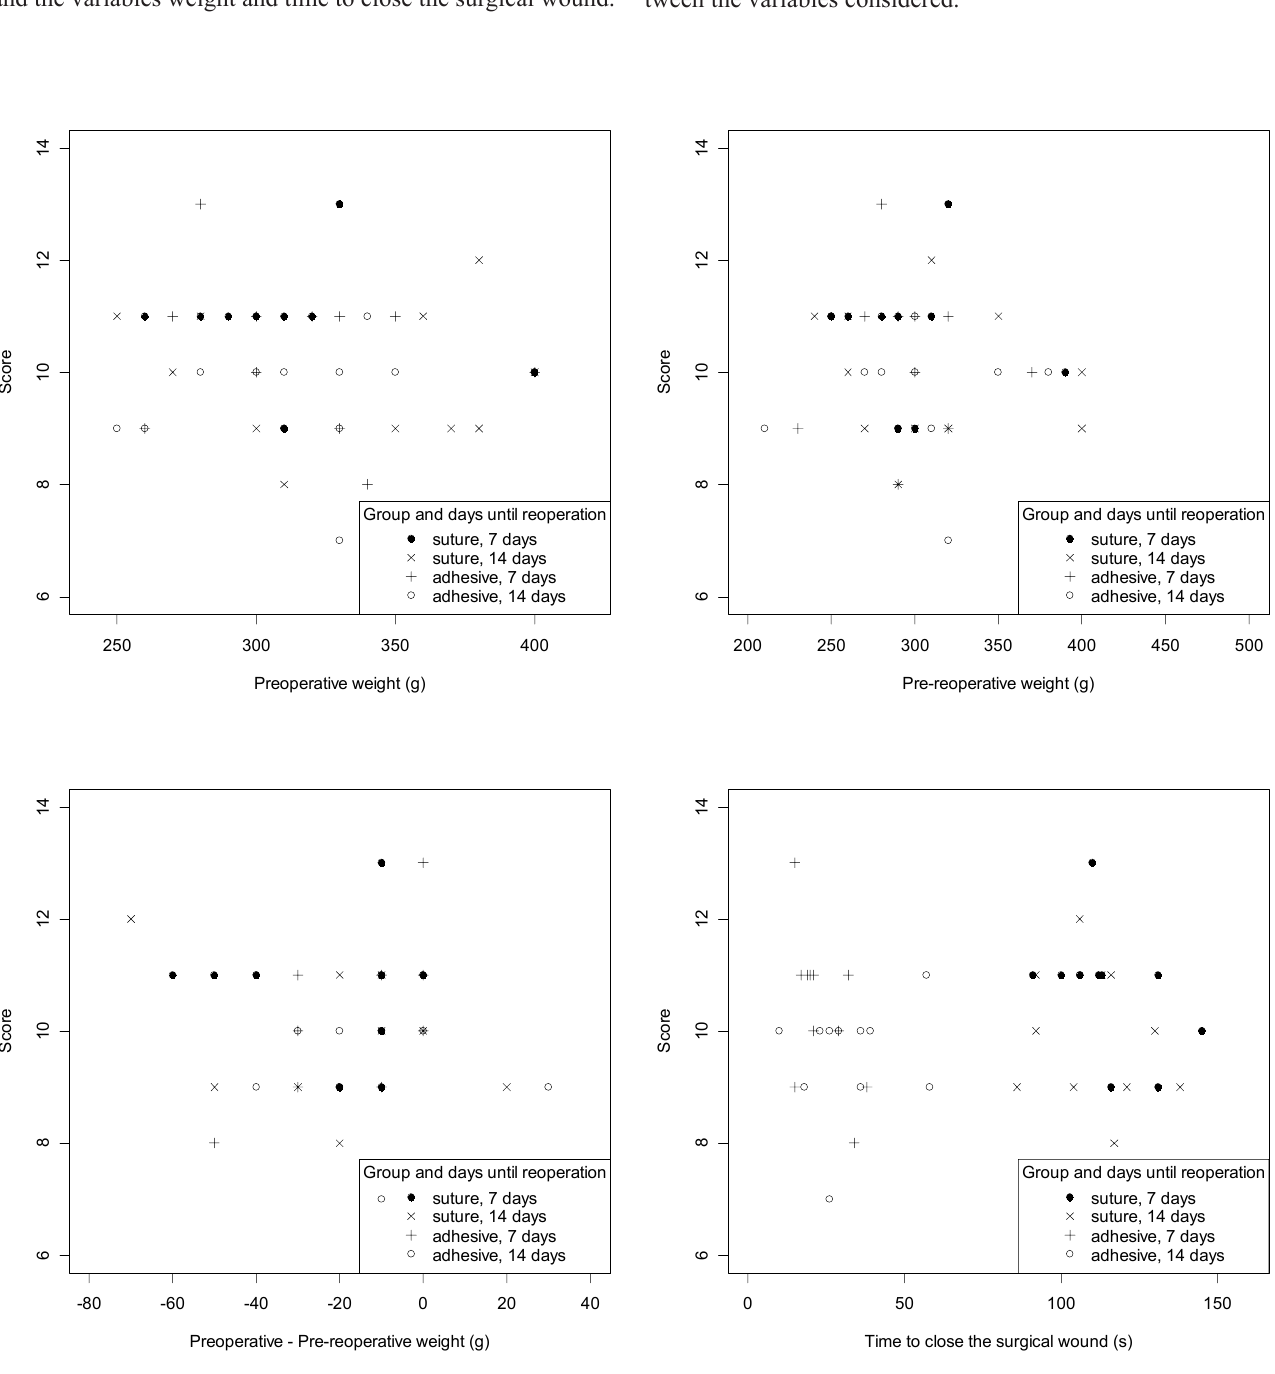
358 - Acta Cirúrgica Brasileira - Vol. 23